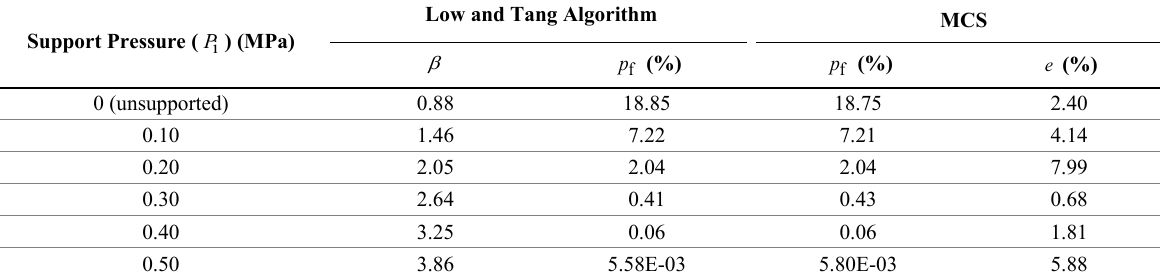
Table 7. Reliability results for the performance function ( ) 1 g x of tunnel